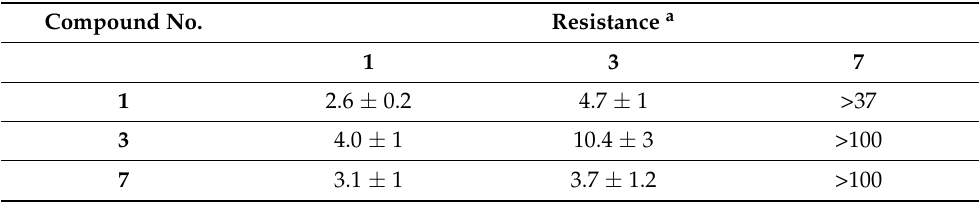
Table 2. Cross-resistance generation in Y. enterocolitica for selected compounds. Compound